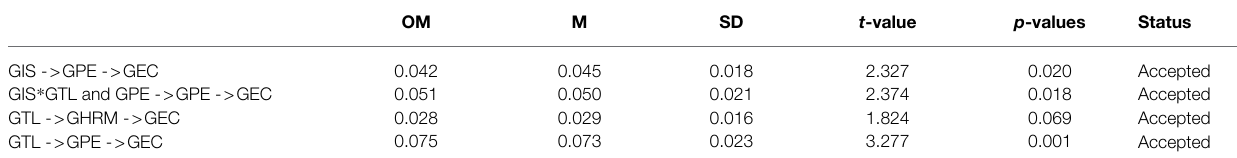
TABLE 8 | Indirect